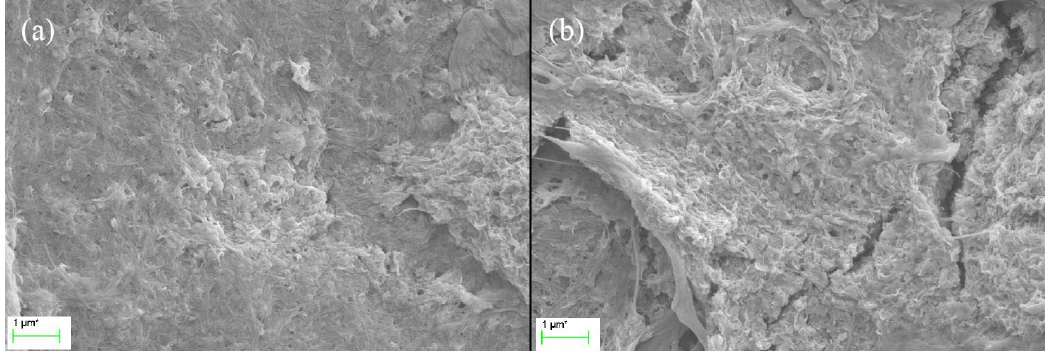
Figure 6. SEM images of ( a ) 5% Eu-BC fluorescent paper and ( b ) 20% Eu-BC fluorescent paper at 10K× magnification.